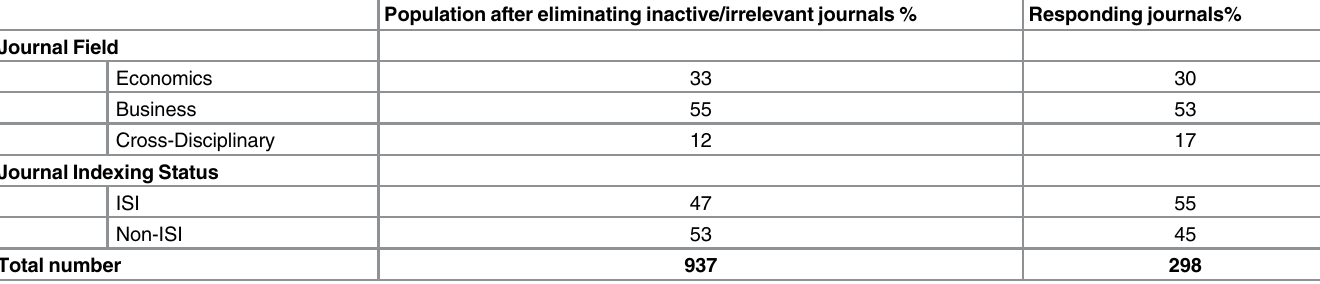
Table 3. Survey II descriptive statistics for journal population and respondents,